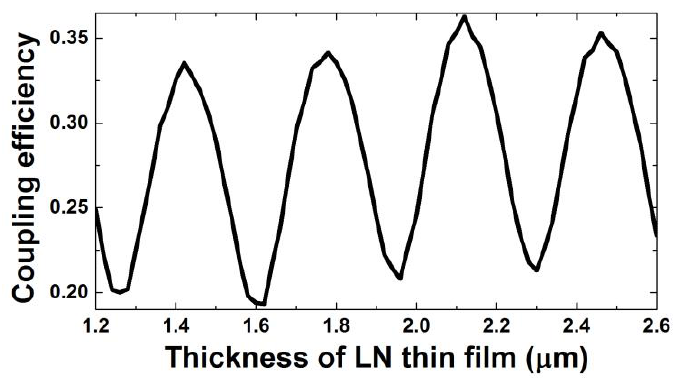
Figure 2. Coupling efficiency at different thicknesses of the LN cladding layer for TE polarization.